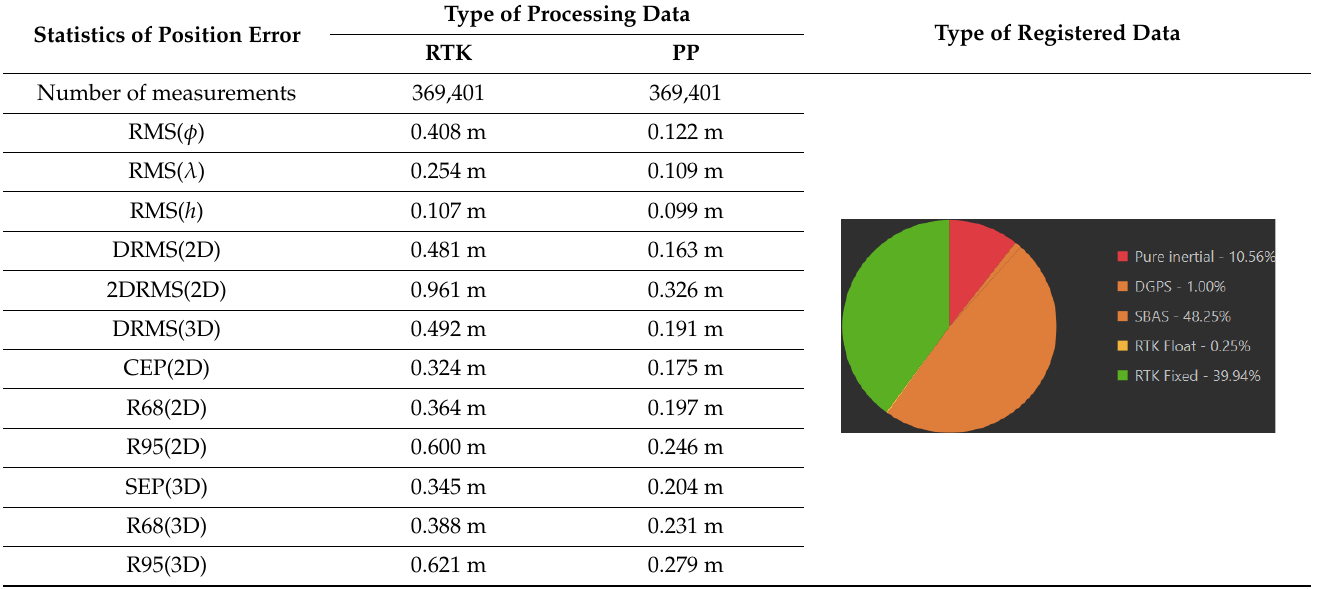
Table 3. Predictable accuracy of the Ekinox2-U system during the GNSS/INS measurements in section no. 2.